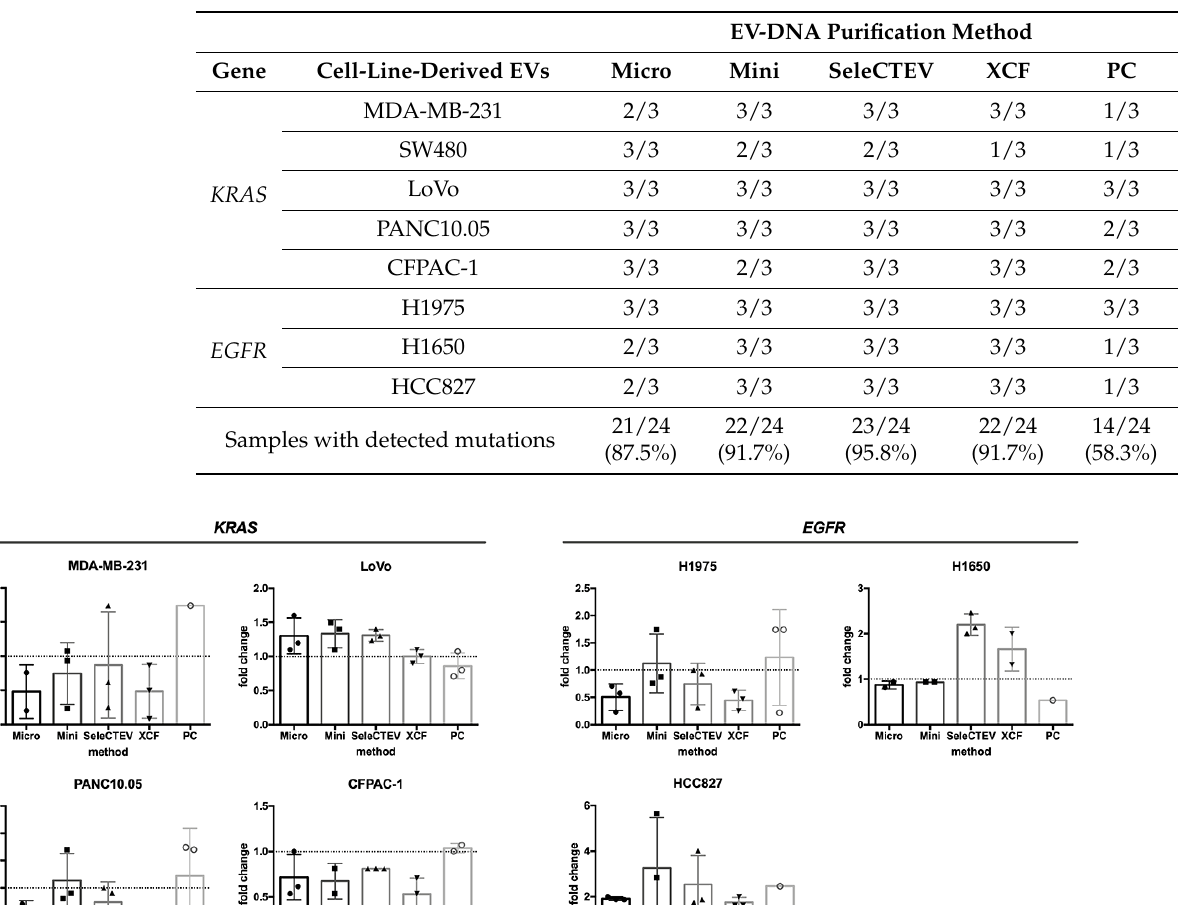
Table 2. Detection of EGFR and KRAS mutations in cancer cells’ EV-DNA that were extracted using (SeleCTEV), XCF Exosomal DNA Kit (XCF), and phenol–chloroform (PC).